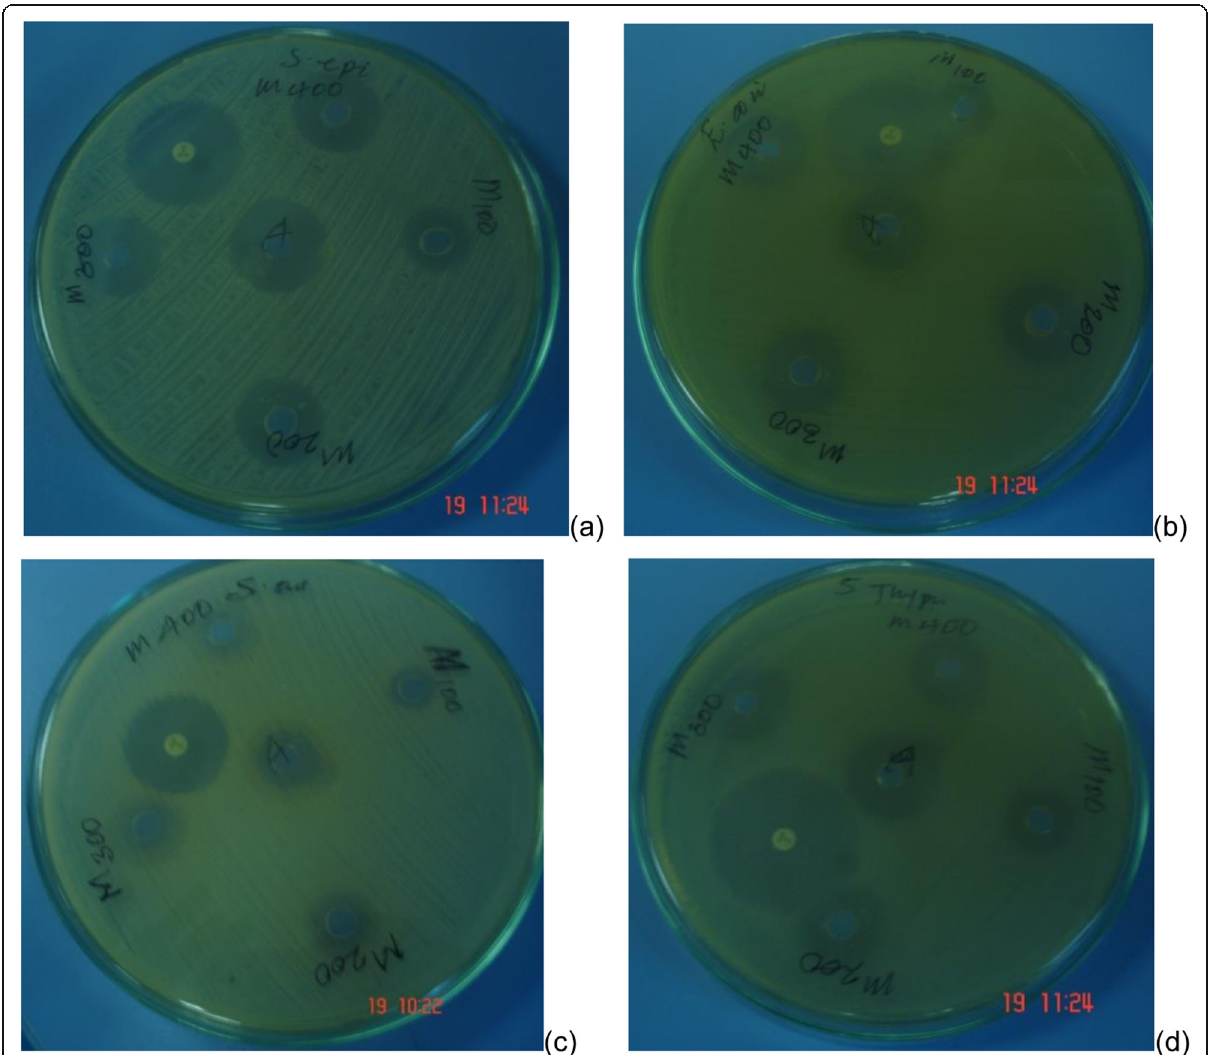
Fig. 6 Inhibition zone of complex 3 in different concentration. Cp., Ciprofloxacin; A, 500 ppm; 400, 400 ppm; 300, 300 ppm; 200, 200 ppm; 100, 100 ppm and a Streptococcus epidermis , b Escherichia coli , c Staphylococcus aurous , and d Salmonella